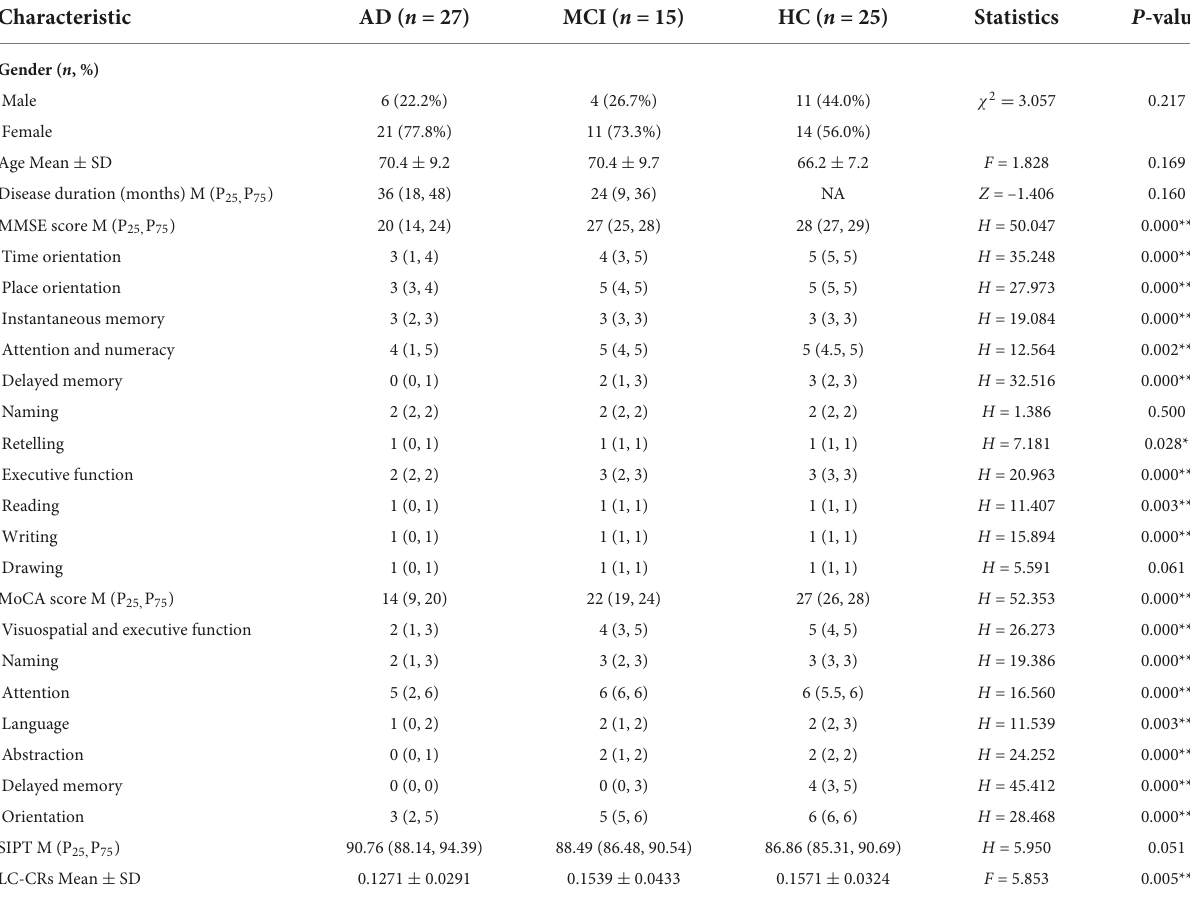
TABLE 1 Demographic characteristics, cognitive scores, and imaging measures of study